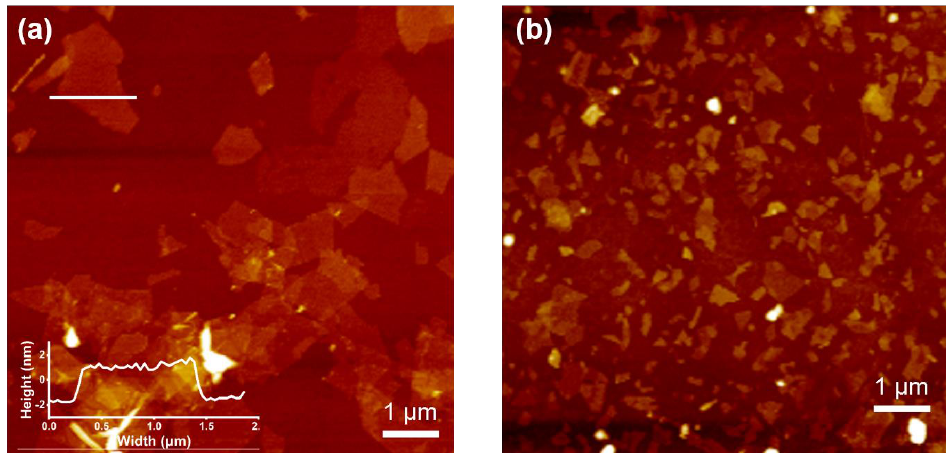
Figure 3. The AFM images of Ti 3 C 2 T x MXene: ( a ) Ultrasound 10 min and ( b ) ultrasound 60 min.